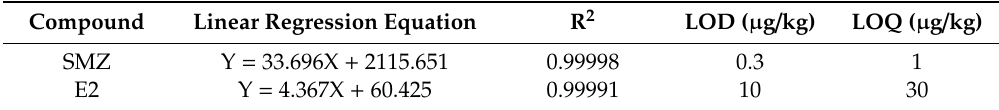
Table 1. Regression equations and detection limits.